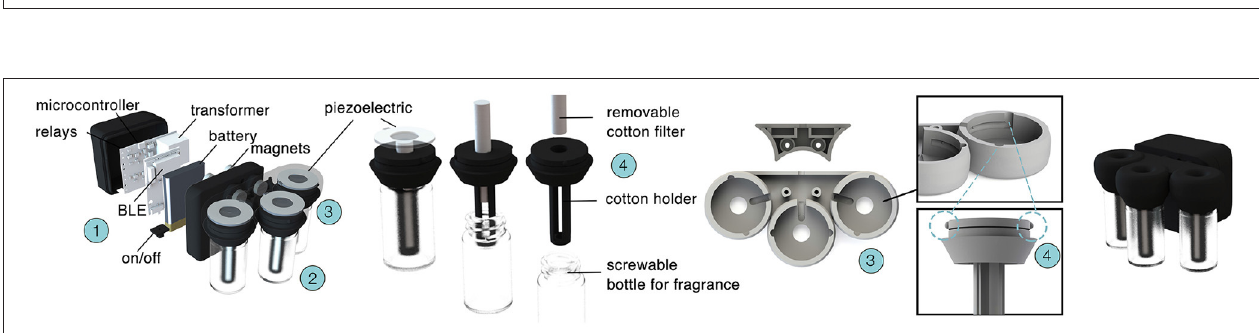
FIGURE 6 | (1) The back case encapsulates the PCB and connects to the front case (2) via a textile thread and magnets. The case holds the piezoelectrics and bottles and has a cavity that connects the textile thread to them (3). The piezoelectrics vibrate at high frequency and release scent when in contact with the cotton filters by soaking the fragrance from the bottle (4). The injection-molded case holds the magnets and wires with two screws. The fragrance can be refilled in two ways: one is by unscrewing the bottle of glass, and the other is by replacing the entire capsule (including cotton filter and cotton holder). The capsule is held using two nubs (4) with an internal mechanism that locks in place by inserting it upwards while rotating 60 ◦ (until the nub passes a minor bump in the path).